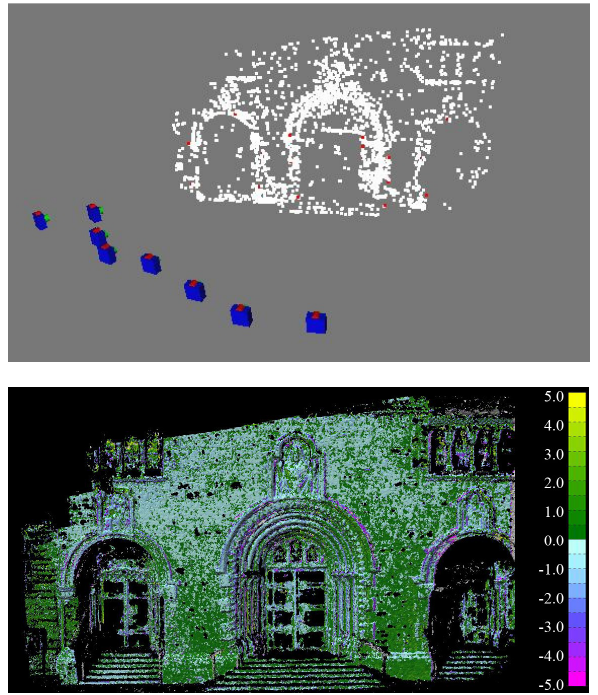
Figure 3. Orientation of Herzjesu sequence. Top : camera stations, tie points and check points (red); bottom : Comparison between laser scanner and photogrammetric DSM (color bar in